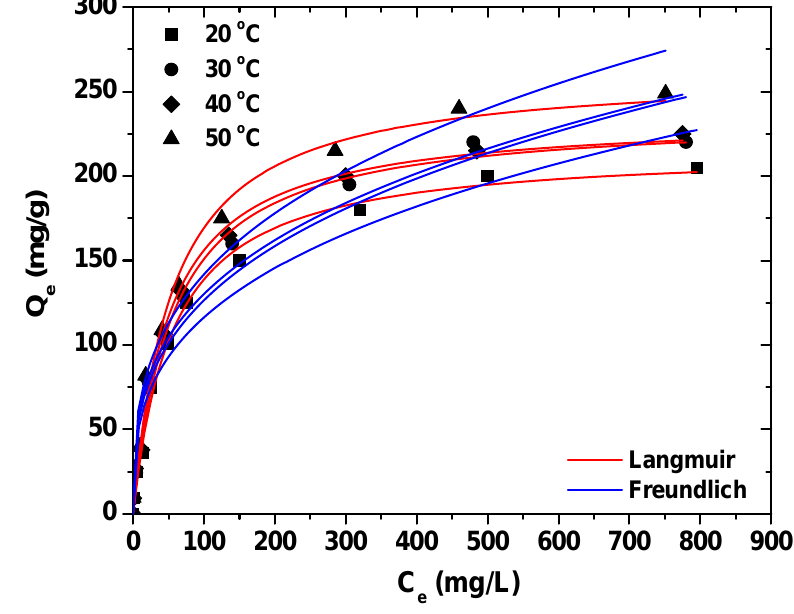
Figure 3. Effect of initial Pb(II) concentration for